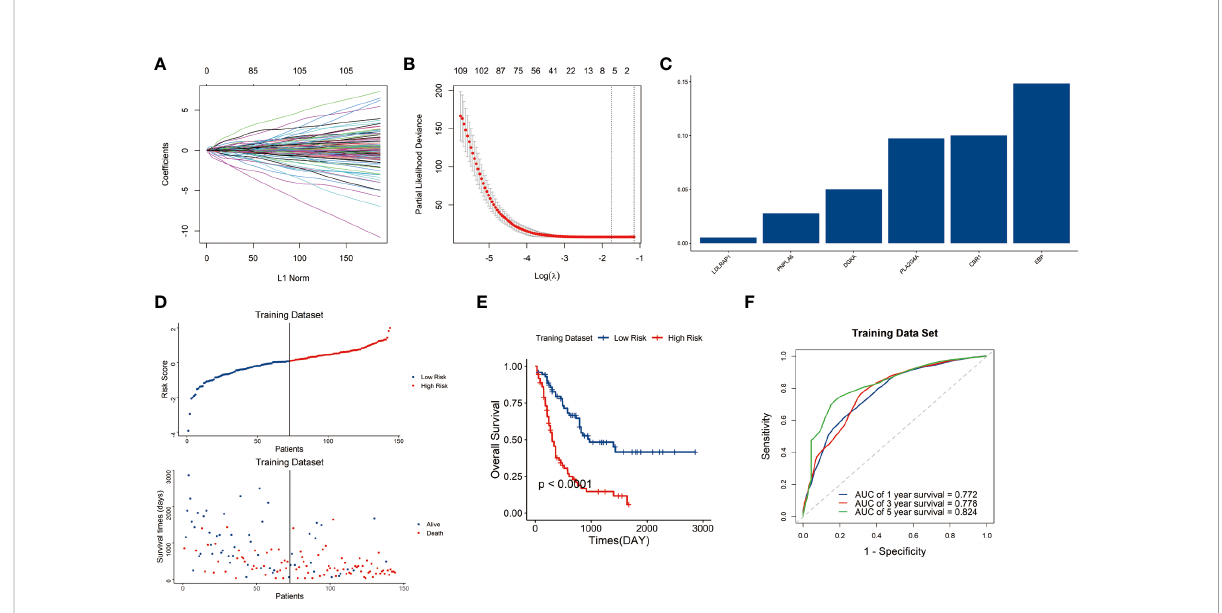
(D) Distribution of the risk score and survival status of each sample. (E) Survival status of patients in the two risk groups classi fi ed by the signature. (F) ROC curves to predict the 1-, 3-, and 5-year